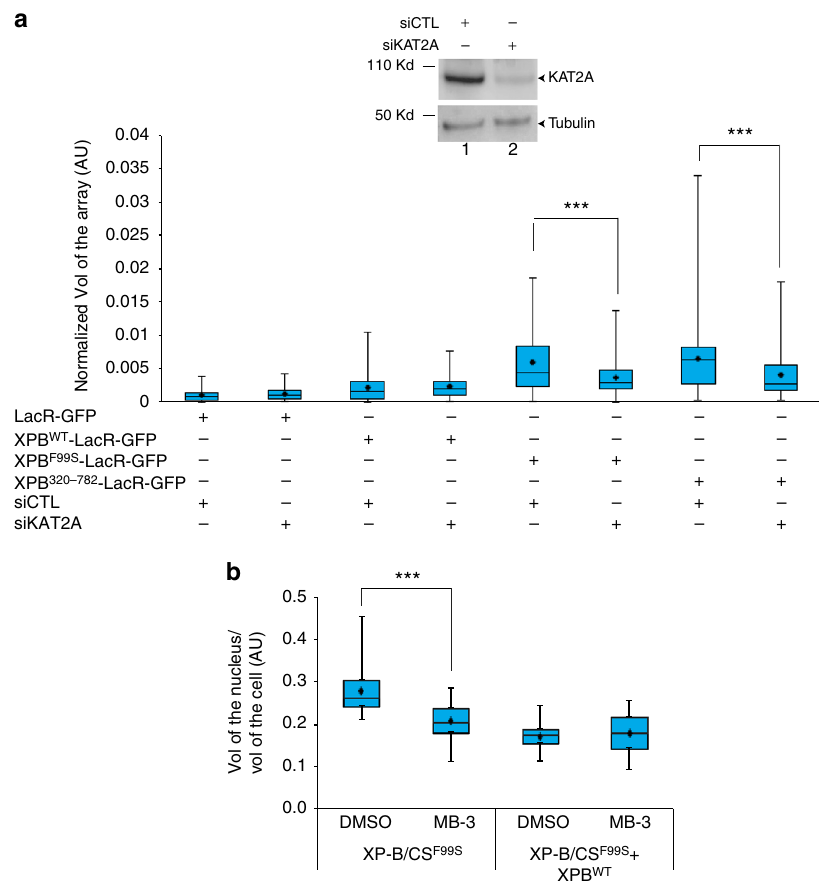
Fig. 5 Higher-order chromatin decondensation induced by XPB mutants is due to KAT2A HAT activity. a U2OS17 cells were transfected either with siCTL or with siKAT2A for 72 h and cell extracts were resolved by SDS-PAGE and immunoblotted using polyclonal rabbit anti-KAT2A or polyclonal rabbit anti- tubulin antibodies. siCTL or siKAT2A transfected cells were re-transfected with either LacR-GFP, XPB WT -LacR-GFP, XPB F99S -LacR-GFP or XPB 320 – 782 - LacR-GFP for 24 h and the relative array volumes (Vol) were quanti fi ed as described above. Signi fi cant p -value are indicated (*** ≤ 0.001) and were obtained using a Kruskal Wallis test. Source data are provided as a Source Data fi le. b XP-B/CS F99S and XP-B/CS F99S + XPB WT cells were treated or not with MB-3 (200 μ M) for 15 h and were subsequently labeled with polyclonal rabbit anti-tubulin and stained with DAPI. Cells were then reconstructed in 3D using Imaris Software (Bitplane) and the volumes of the cells and their nuclei were measured. The whisker box plot shows the volume of the nucleus/ volume (Vol) of the cell (at least 30 cells for each condition, error bars represent SD from three independent experiments). The signi fi cant p -value is indicated (*** ≤ 0.001) and were obtained using a Kruskal Wallis test. Source data are provided as a Source Data fi